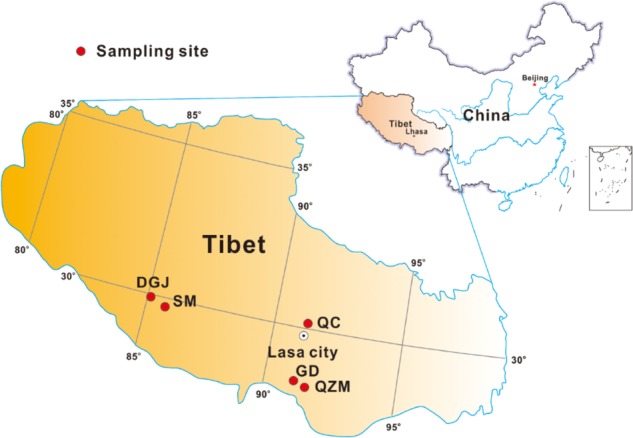
Geographic map showing the sampling locations in this study (including zones of QZM, DGJ, QC, SM, and GD as indicated in the M&M).